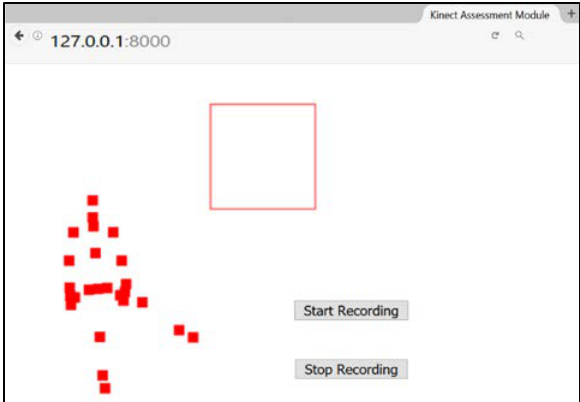
Figure 2 | Patient’s avatar displayed in the Web browser.